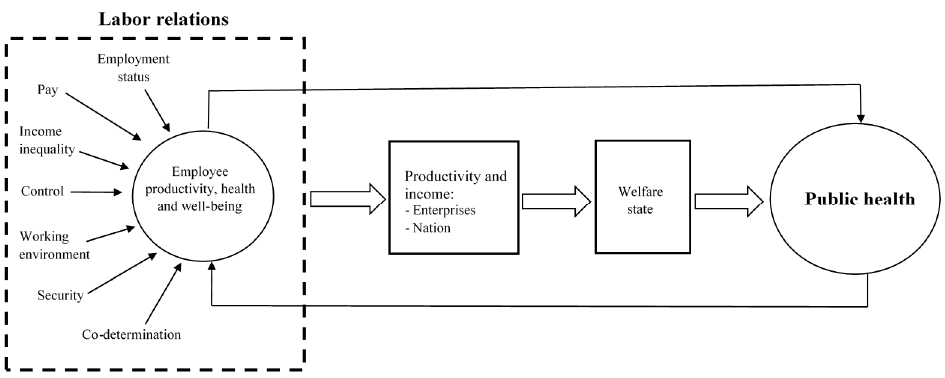
Figure 1. Relationships between labor relations and public health.